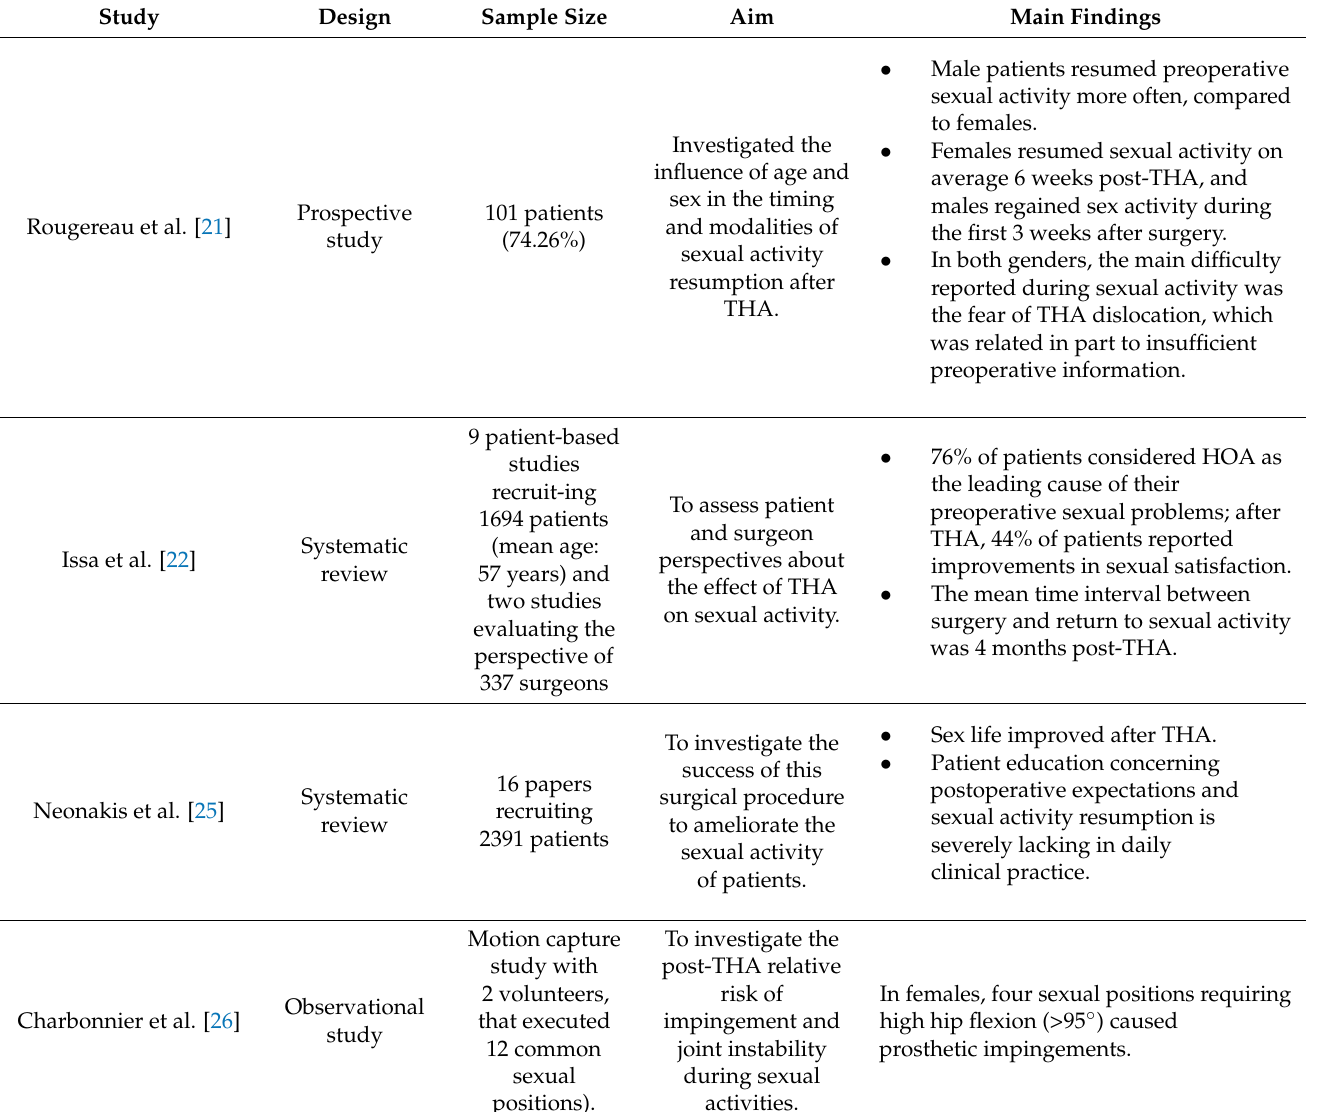
Table 3. Studies investigating sexual activity after THA and gender